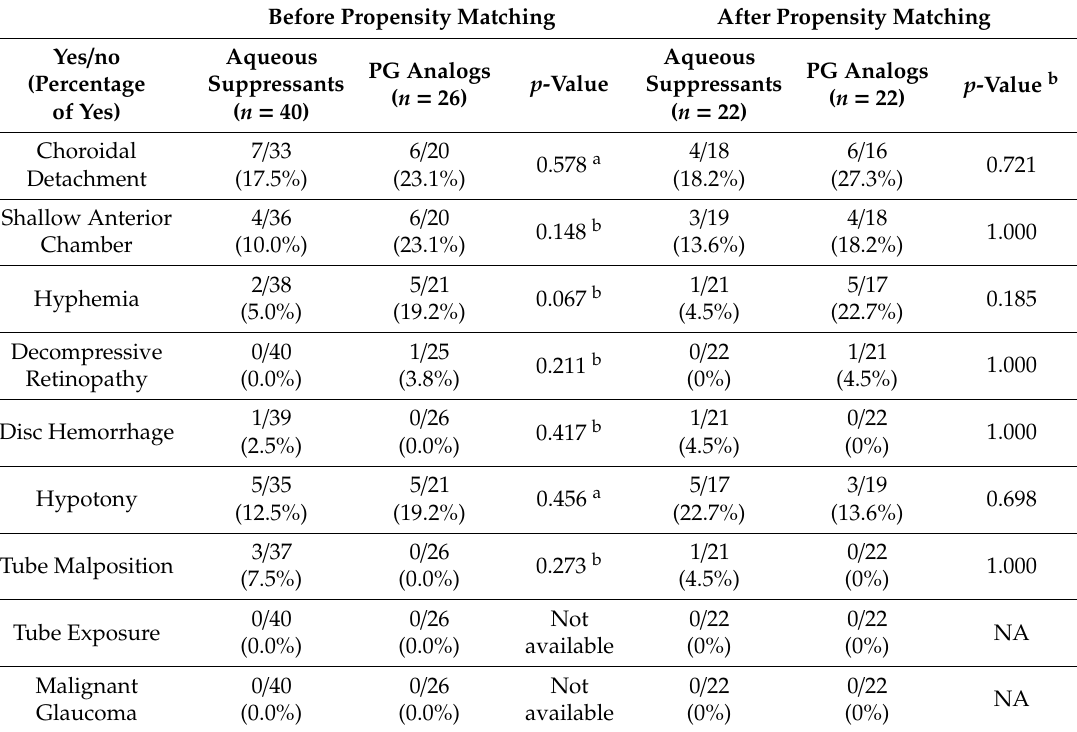
Table 2. Postoperative complications.